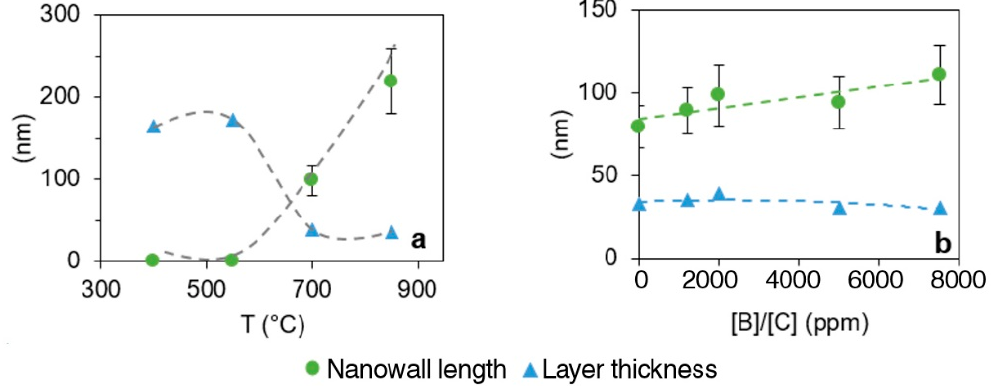
Figure 3. ( a ) Nanowall length and layer thickness for B ‐ CNW growth at 400 °C, 550 °C, 700 °C, and 850 °C at a 2000 ppm [B]/[C] ratio; ( b ) nanowall length and layer thickness for B ‐ CNW growth at 0, 1200, 2000, 5000, and 7500 ppm [B]/[C] at 700 °C.